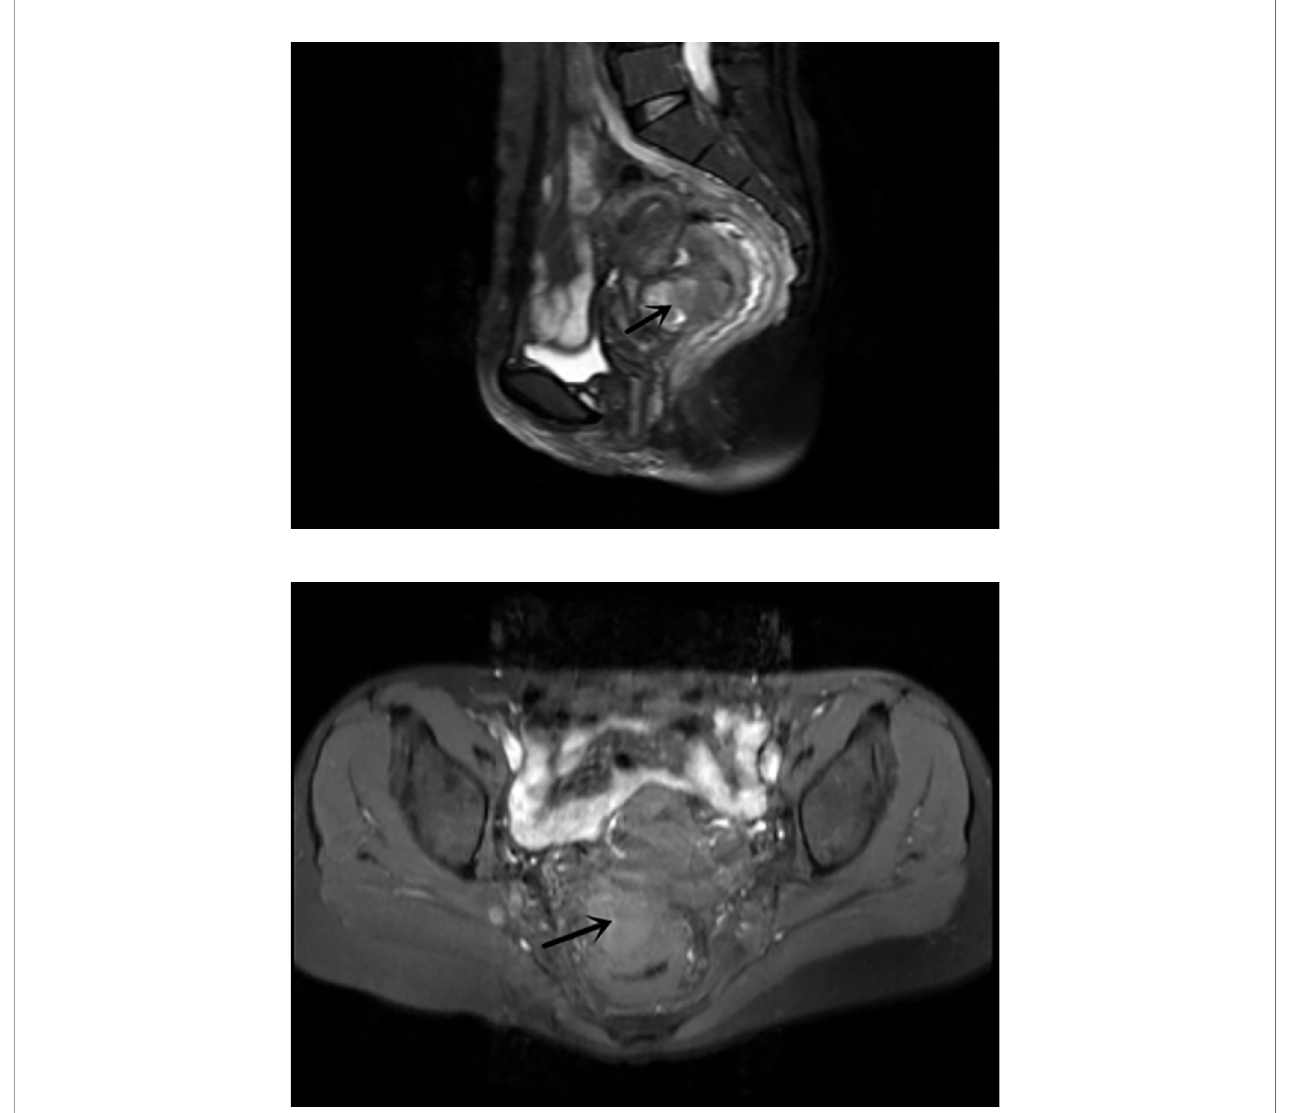
FIGURE 2 | Pelvic MRI: Hybrid signal packet block at the right rear of